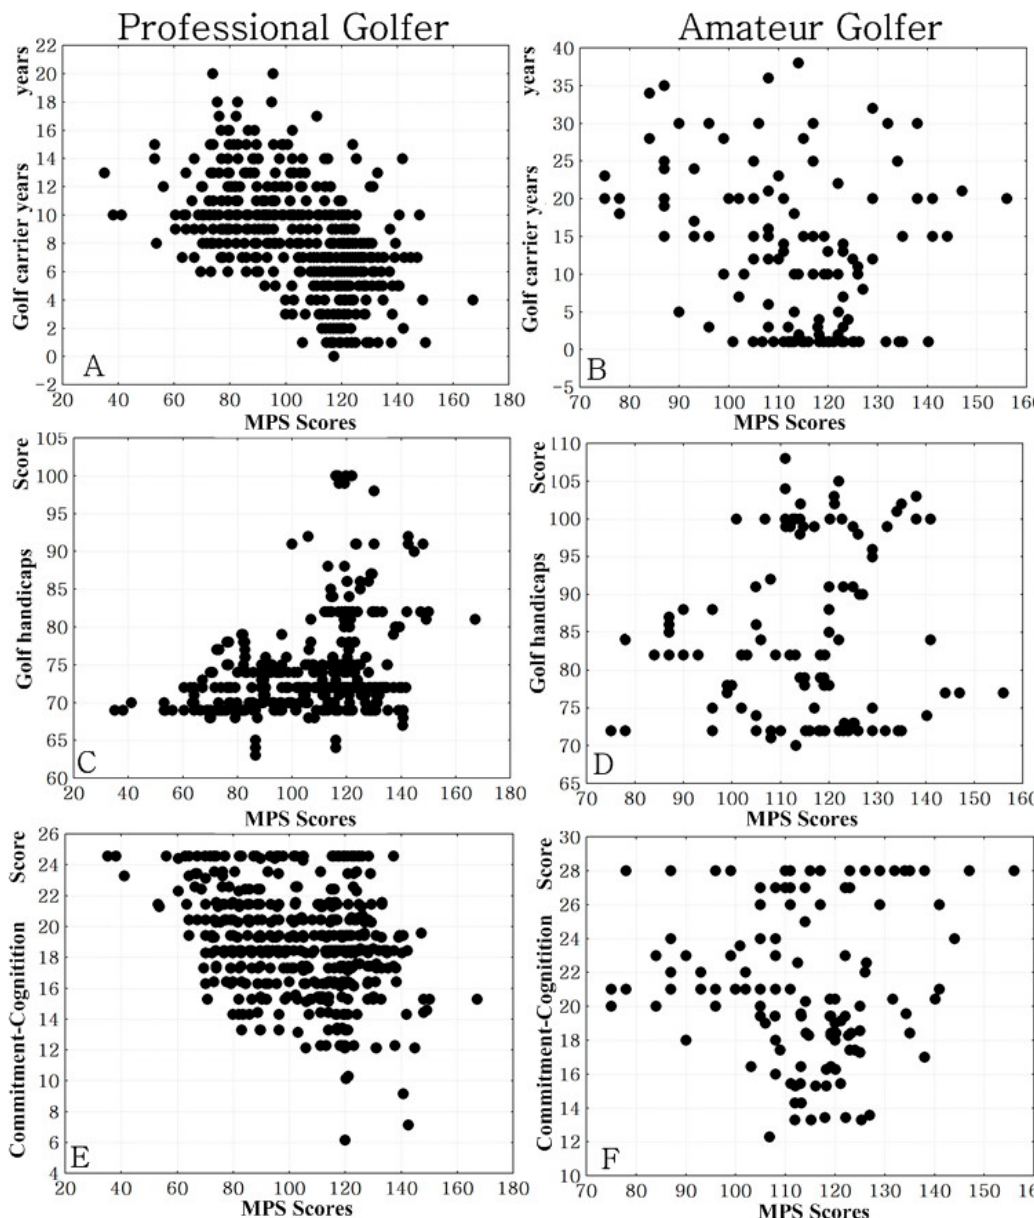
Figure 1. Scatter plot between perfectionism, commitment, golf handicap, and carrier years. MPS: Multidimensional Perfectionism Scale; ES: effect size: ( a ) controlling for age and training time, the partial correlations between golf career length (years) and MPS total scores in professional golfers, r = − 0.38, p < 0.01, − 0.472 < 95% CI < − 0.323, moderate ES; ( b ) controlling for age and training time, the partial correlations between golf career length (years) and MPS total scores in amateur golfers, r = − 0.53, p < 0.01, − 0.642 < 95% CI < − 0.465, large ES; ( c ) controlling for age, golf handicap, and training time, the partial correlations between golf handicap and MPS total scores in professional golfers, r = 0.33, p < 0.01, 0.281 < 95% CI < 0.435, moderate ES; ( d ) controlling for age and training time, the partial correlations between golf handicap and MPS total scores in amateur golfers, r = 0.12, p = 0.02, 0.002 < 95% CI < 0.253, small ES; ( e ) controlling for age, golf handicap, and training time, the partial correlations between commitment-Cognition scores and MPS total scores in professional golfers, r = − 0.30, p < 0.01, − 0.388 < 95% CI < − 0.228, moderate ES; and ( f ) controlling for age, golf handicap, and training time, the partial correlations between commitment-Cognition scores and MPS total scores in amateur golfers, r = 0.07, p = 0.61, − 0.108 < 95% CI < 0.1485, small ES.